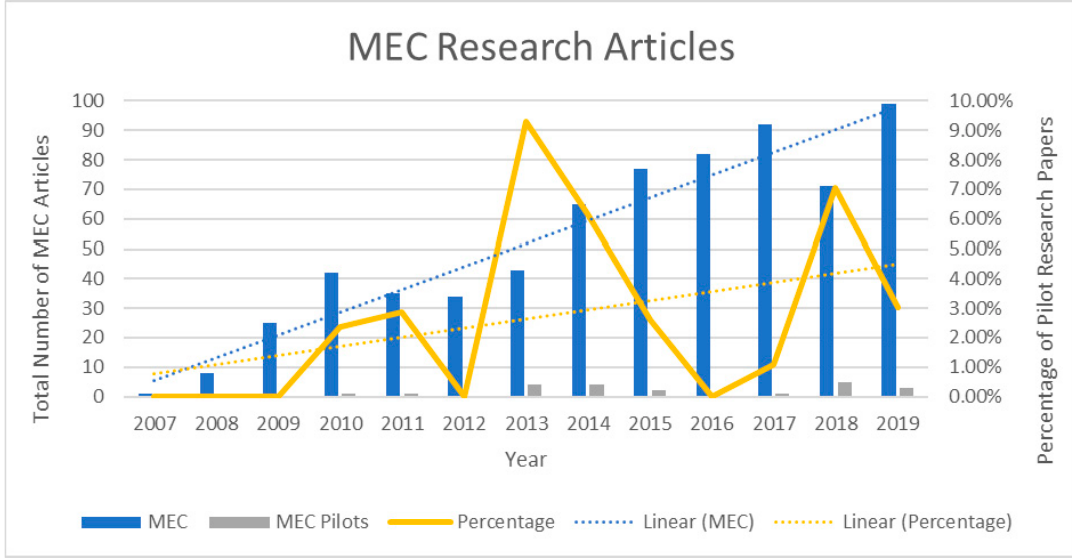
Figure 4. Representation of the number of previous studies conducted investigating the use of MECs for wastewater treatment at lab-scale (blue) and pilot-scale (yellow). For the number of articles for MECs a Google Scholar Search was carried out to include (allintitle: “Microbial Electrolysis”). For MEC pilot-scale, a second Google Scholar was used (allintitle: Scaleup OR Scale-up OR Scaling OR Pilot “Microbial Electrolysis”).